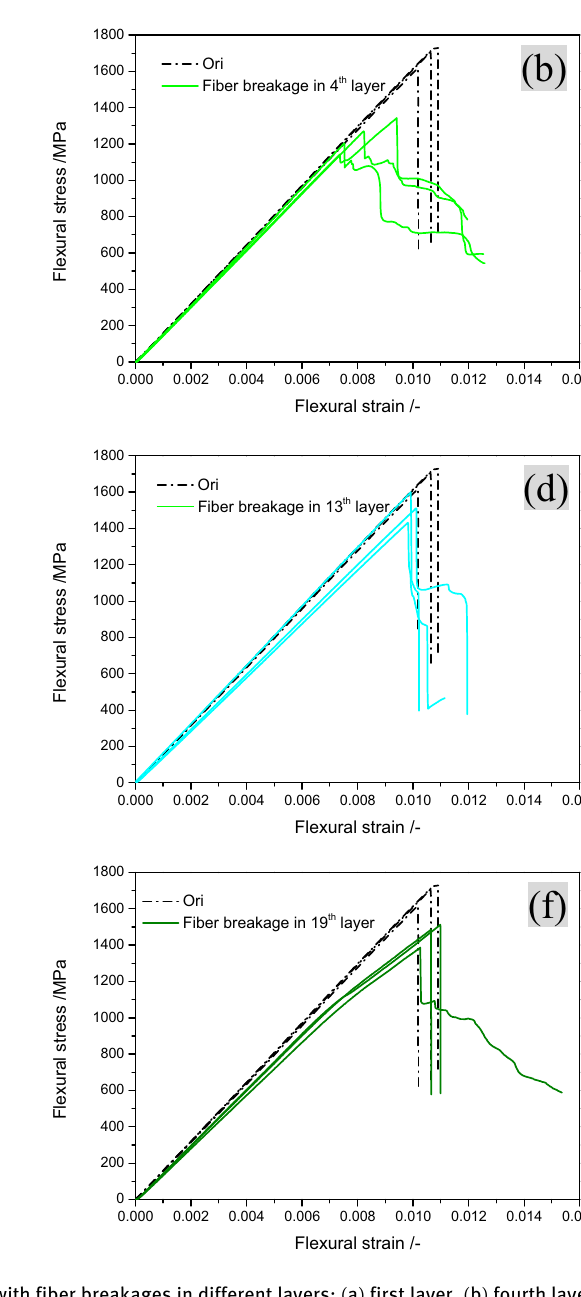
Figure 4: Typical flexural stress – strain curves of CF/epoxy laminates with fiber breakages in different layers: ( a ) first layer, ( b ) fourth layer, ( c ) seventh layer, ( d ) 13th layer, ( e ) 16th layer, and ( f ) 19th